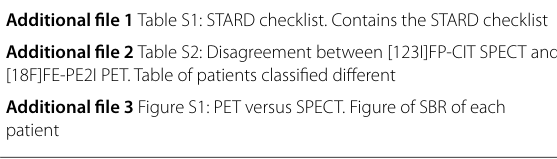
Additional file 3 Figure S1: PET versus SPECT. Figure of SBR of each